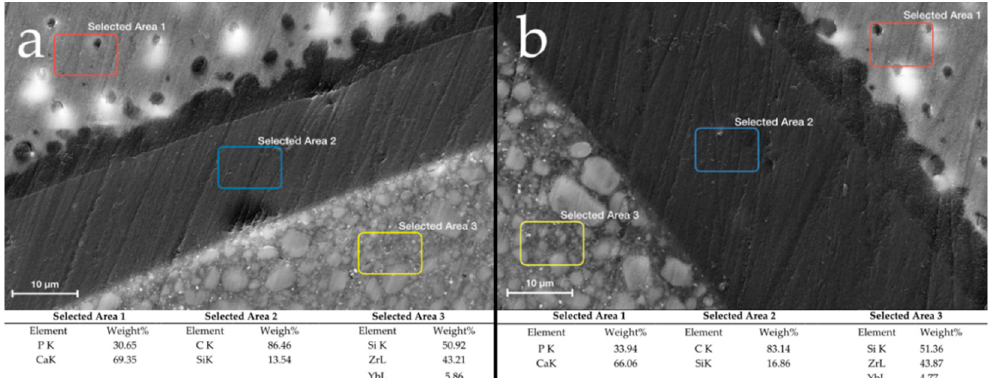
Figure 6. The scanning electron micrographs displayed the three different structure of tooth–interface surface of BG and BT groups (( a , b ) respectively). Selected Area 1: Enamel surface (E); selected Area 2: Adhesive layer (Ad); Selected Area 3: BFC surface (BFC). EDS results of BG and BT groups are reported in the table analysing the different elements as follow: Phosphorous (P), calcium (Ca), carbonium (C), silicon (Si), zirconium (Zr), and ytterbium (Yb).